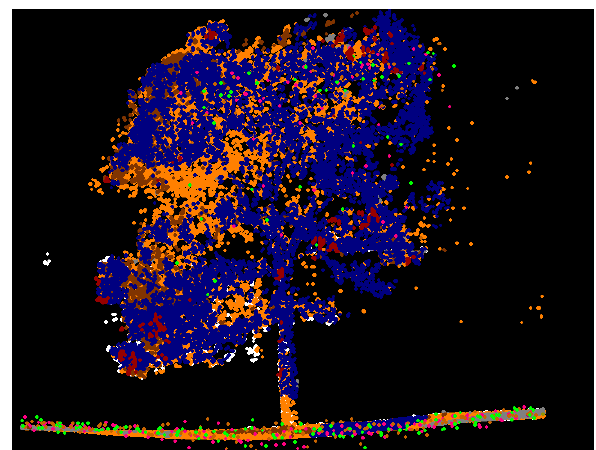
Figure 7: A tree crown and a ground segment with points originating from multiple airborne and terrestrial